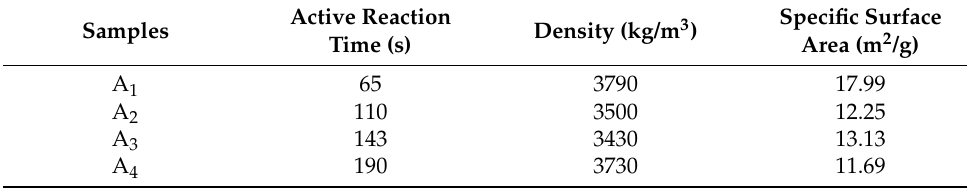
Table 2. The mineral composition of cement clinker (wt/%). Table 3. The basic properties of four